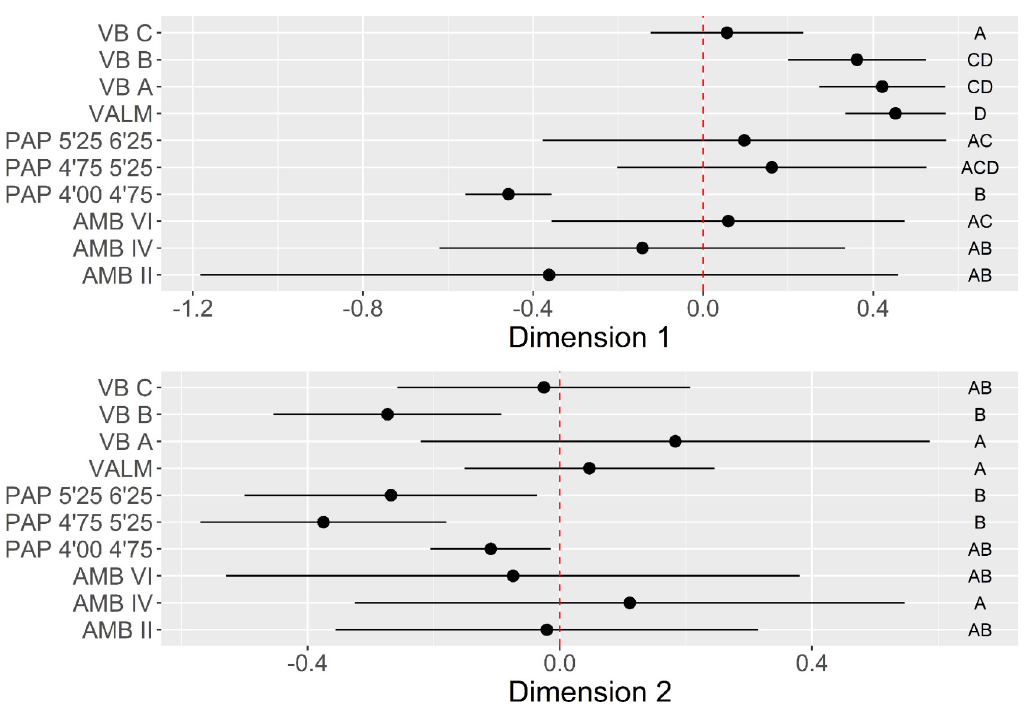
Fig 16. Core use multi-comparison bootstrap ANOVA. Error bars represent 95% confidence interval from the mean. Contexts sharing the same set of letters do not present statistically significant difference (p-value � 0.05).